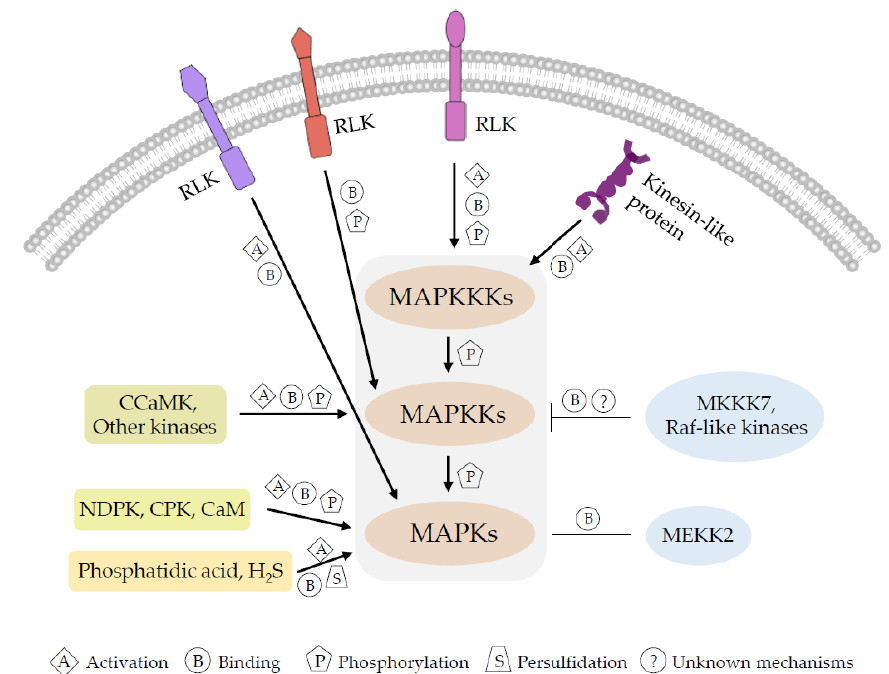
Figure 1. Activation modes of plant MAPK cascades. Each tier of the signaling cascade can be activated by different modes. MAPKKKs can be activated by kinesin-like proteins and receptor-like kinases (RLKs) through direct binding and/or phosphorylation. MAPKKs can also be directly activated by RLKs, or other protein kinases such as calcium/calmodulin-dependent protein kinase (CCaMK), through binding or phosphorylation. The activation modes of MAPKs vary considerably. Proteins including NDP kinase (NDPK), calcium-dependent protein kinase (CPK), and calcium- binding protein (CaM) activate MAPKs through binding and/or phosphorylation. Phosphatidic acid and H 2 S promote MAPKs activation through direct binding and persulfidation, respectively. It is necessary to note that some MAPKKKs, especially some Raf-like kinases, do not function as genuine MAPKKKs, although they are still involved in the regulation of MAPK cascades. Arrows and T lines indicate positive and negative regulations, respectively.